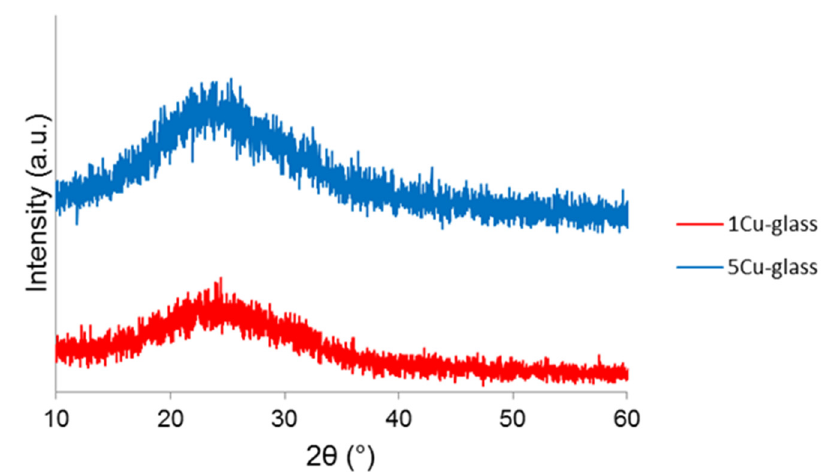
Figure 2. Wide-angle X-ray powder diffraction (XRPD) patterns of copper-doped materials after calcination.